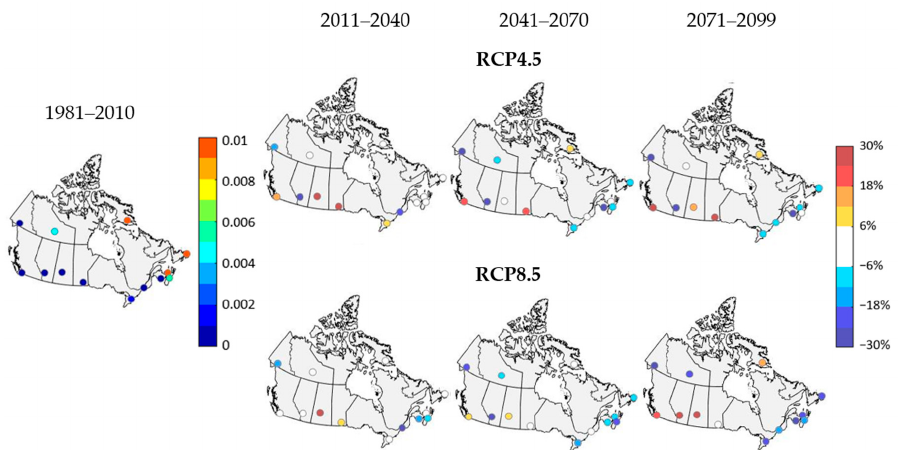
Figure 9. Probability of occurrence of crosswind larger than 15 knots for the longest runway for current climate (left), and their projected changes (in %, right) for three future periods for RCP4.5 (top) and RCP8.5 (bottom) scenarios. Atmosphere 2020 , 11 , x FOR PEER REVIEW